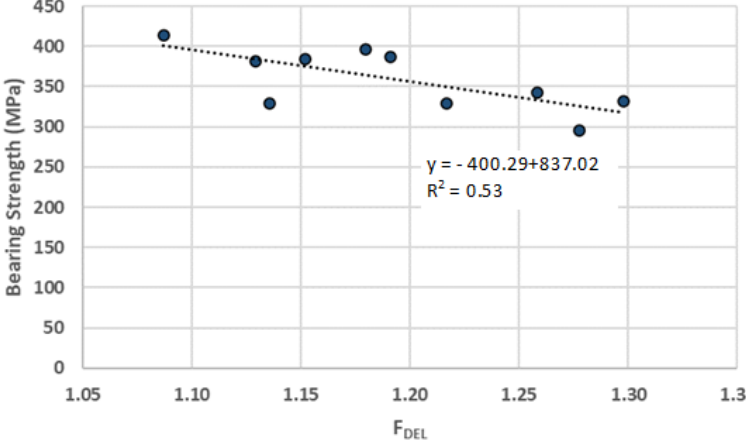
Figure 4. Correlation between Damage and Bearing strength for cross-ply plates.